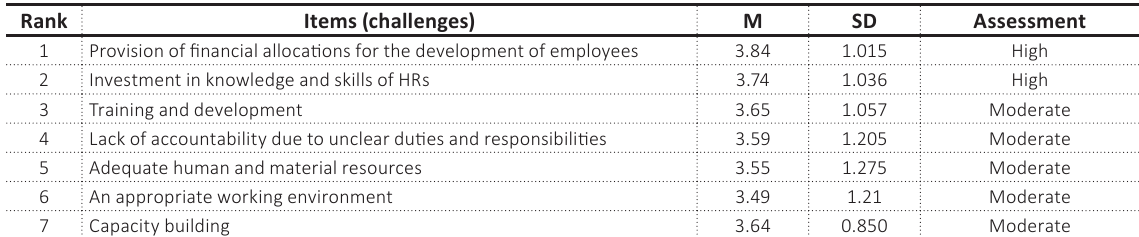
Table 7. Respondents’ assessment of the level of capacity building challenges facing local